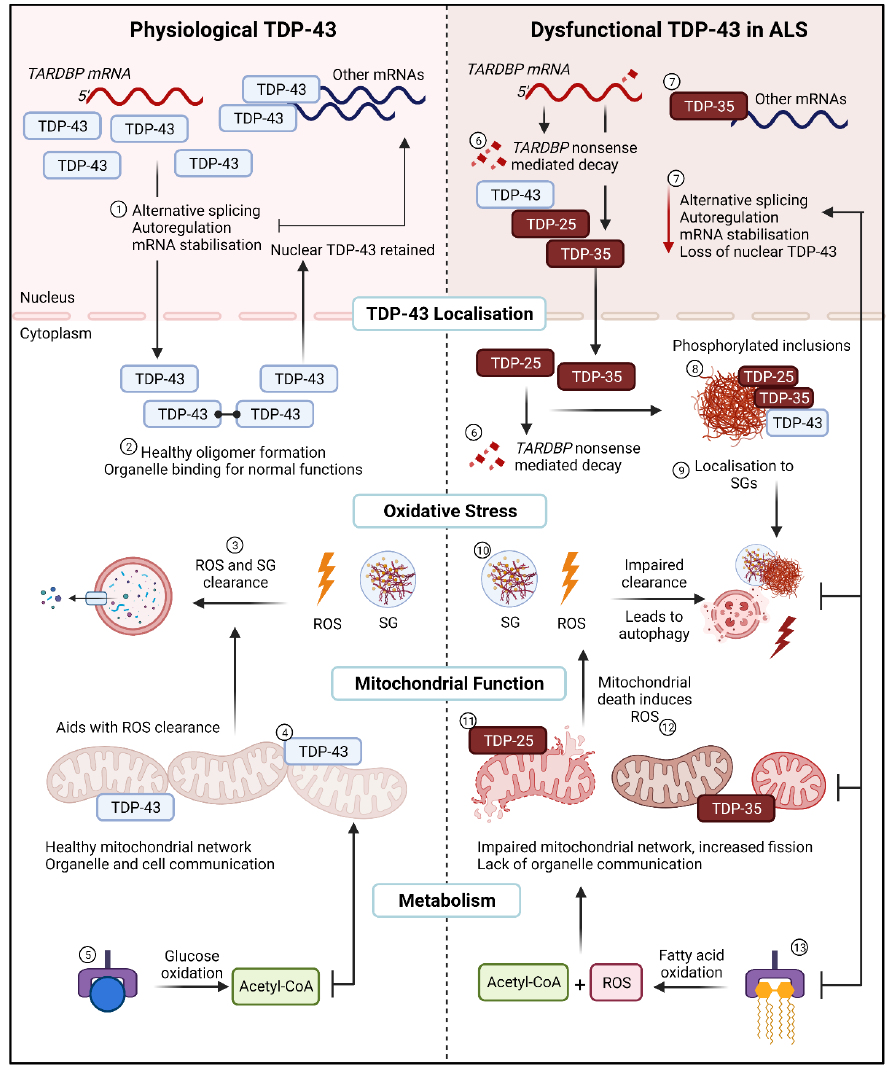
Figure 3. The relentless TDP-43 positive feedback loop in ALS. ( Left ), Physiological TDP-43. (1) In healthy cells TDP-43 regulates normal RNA metabolic functions such as alternative splicing, autoregulation, and mRNA stabilisation. (2) TDP-43 oligomers are generated in the cytoplasm and cleared upon return to the nucleus. (3) Under normal oxidative stress conditions, ROS and SG are cleared by the aid of healthy mitochondria and a lack of mutant TDP-43 aggregating with SGs. (4) Full-length TDP-43 binds to the mitochondria to undergo normal functions and aids in organelle and cell communication. (5) Glucose as the main substrate for energy utilisation for ATP in mitochondria is utilised. ( Right ), Dysfunctional TDP-43 in ALS. (6) Dysfunctional TDP-43 transcribes and translates fragmented TDP-43, some fragmented are sent for nonsense mediated decay in the nucleus or the cytoplasm. (7) A loss of RNA metabolic functions is observed alongside a loss of nuclear TDP-43. (8) TDP-43 and TDP-43 fragments localise to the cytoplasm, where they are phosphorylated and form aggregates. (9) These aggregates lead to sequestration into SGs. (10) Impaired clearance of ROS and SG results in autophagy and cell death through a lack of apoptosis. (11) Mutant TDP-43 bind to mitochondria to impair the mitochondrial network, as well as mitochondrial signalling and function. (12) Lack of mitochondrial function creates a feedback loop with impaired oxidative stress and ROS clearance. (13) Switch from glycolysis to fatty acid oxidation induces ROS alongside Acetyl-CoA for substrate utilisation in mitochondria. SG; stress granules, ROS; reactive oxygen species. Created with BioRender.com accessed on 12 July